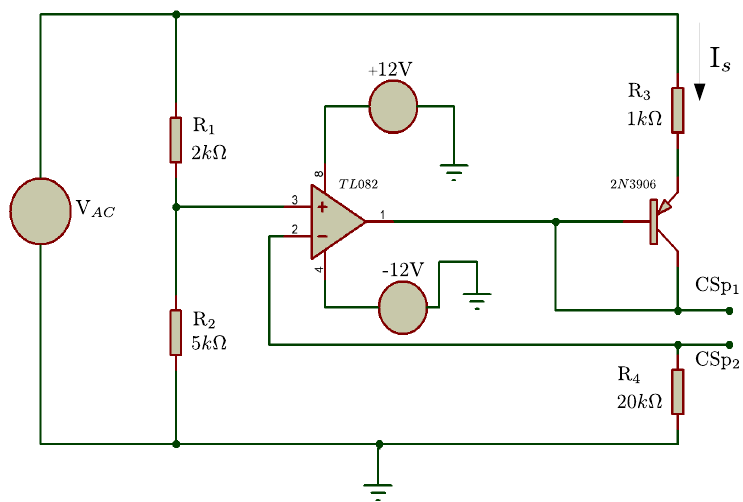
Figure 5. Constant current source circuit, I s = 91.42 µ A.